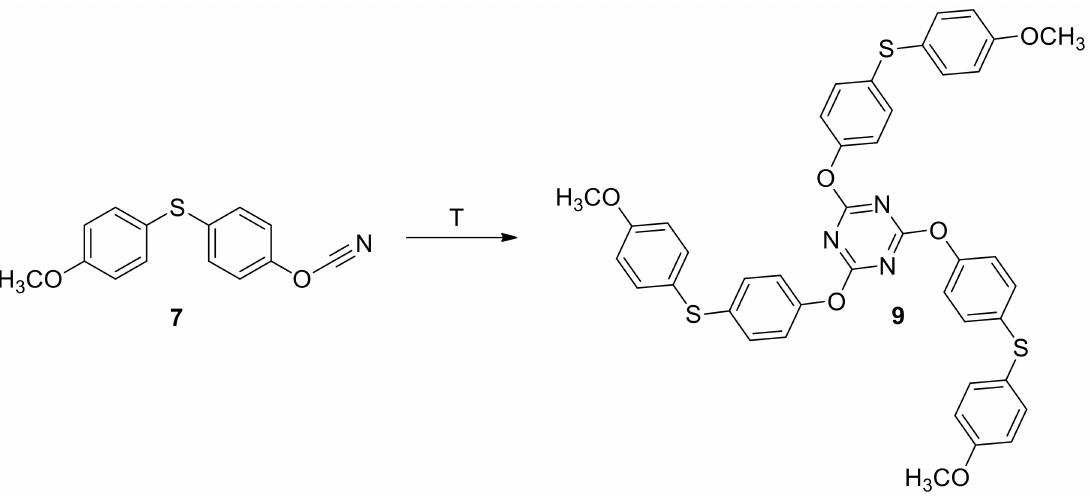
Figure 5. Scheme of cyclotrimerization of compound 7 .